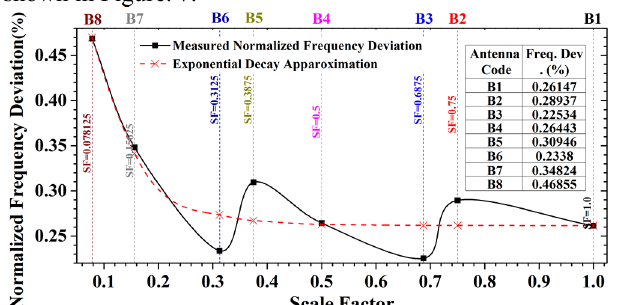
Figure. 7. The normalized frequency deviation between simulation and measurement results.